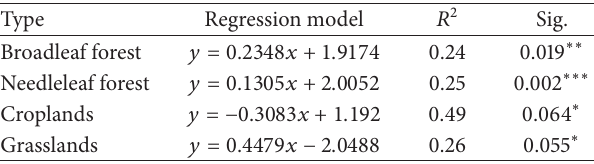
Table 5: Changing trends of broadleaf forest, needleleaf forest, croplands, and grasslands (with the square of correlation coefficient ( 𝑅 2 ), significance level (Sig.), and regression models).